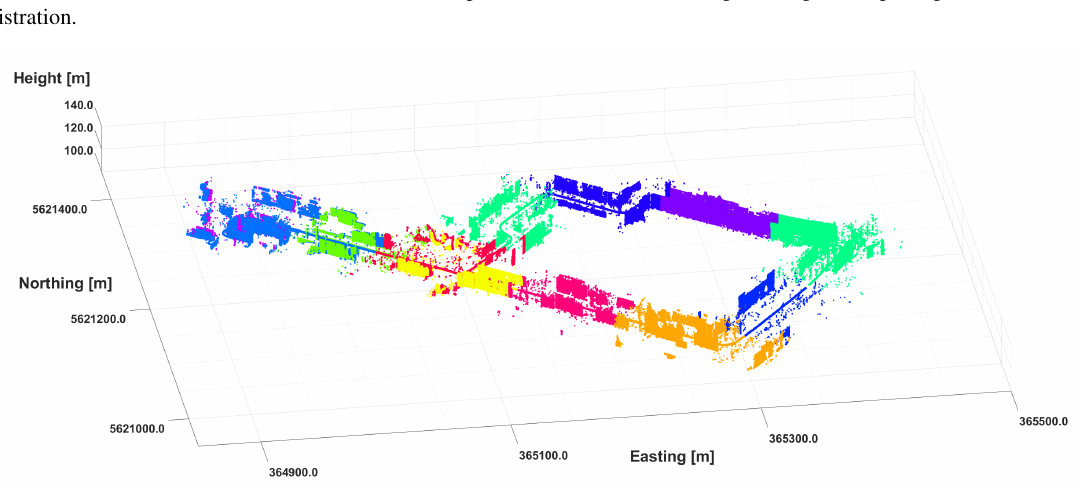
Figure 10. The segmentation of the point cloud in 12 segments (different colors). Overlapped colored areas represent segments from outward and return